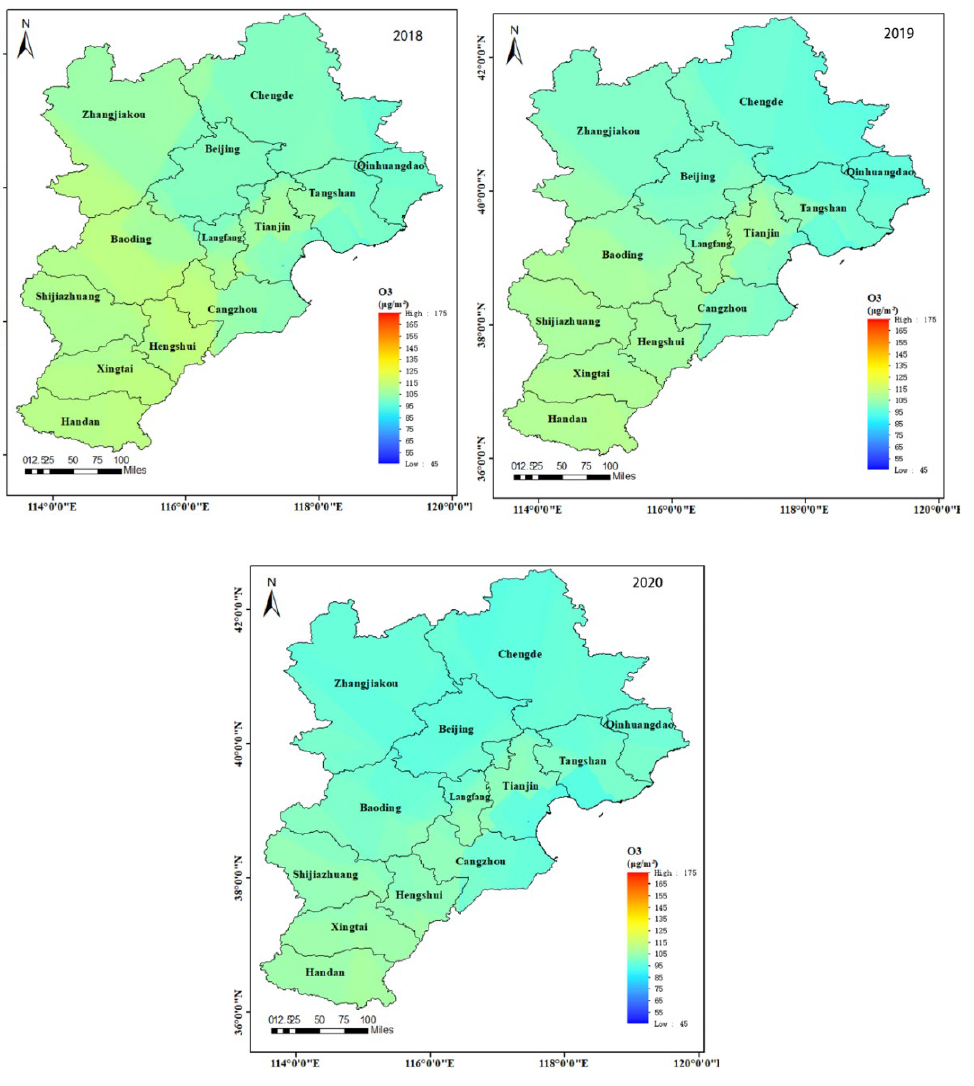
Figure 4. Distribution of O 3 _8h concentration from 2018 to 2020 in Jing-Jin-Ji region in China. Table 2. Number of days exceeding the ozone limited value of 160 μg/m 3 from 2018 to 2020 in Jing-Jin-Ji region in China.